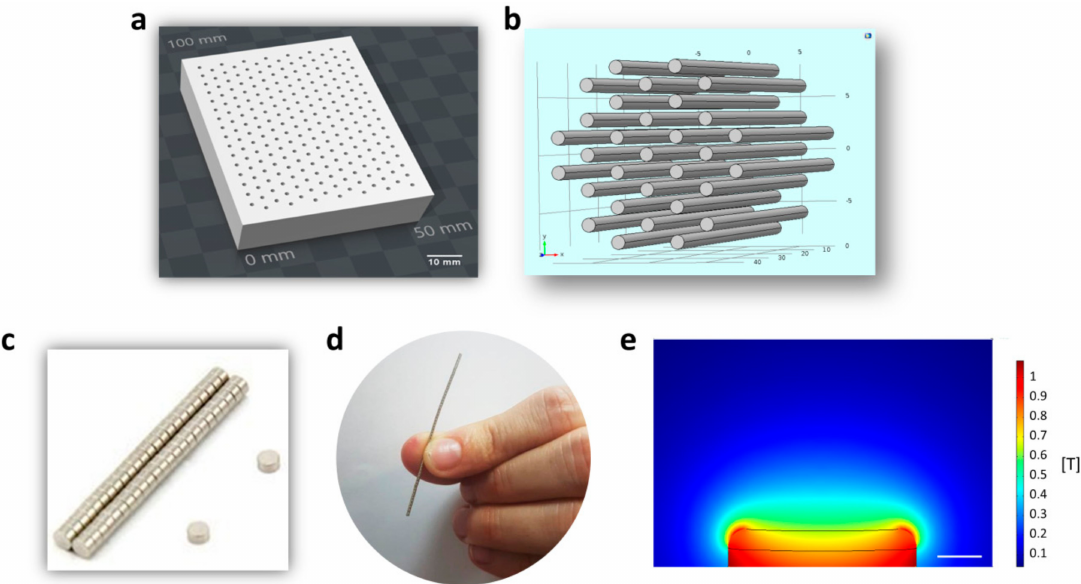
Figure 3. ( a ) A beehive block design illustration; ( b ) Magnetic rods ordered in hexagons grid; ( c ) Circular neodymium magnets piled to rods; ( d ) Size illustration of magnetic rods; ( e ) Simulation of magnetic flux density in COMSOL software. The image presents a side view of magnetic flux density of magnet rod. Intensity is color coded (low intensity in dark blue, high intensity in red). Scale bar = 0.25